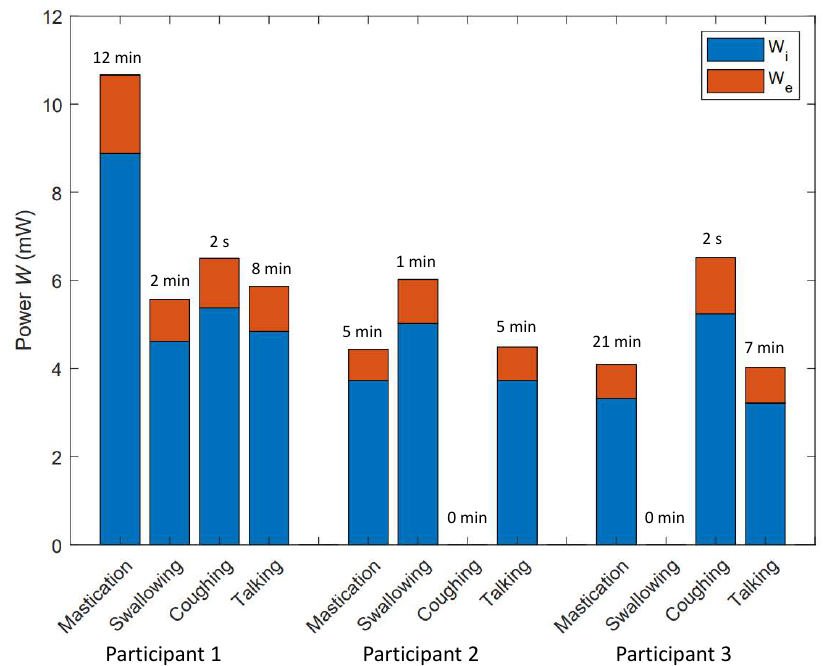
Figure 7. Mean power per jaw joint activity evaluated for three test subjects.